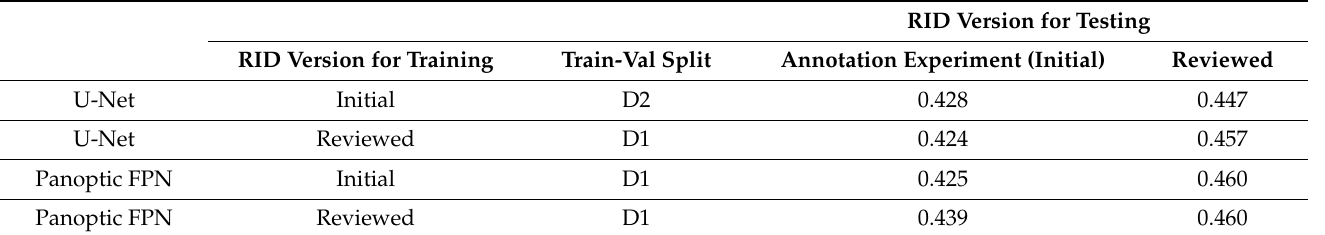
Table 2. IoUs of selected CNNs trained and tested on initial and reviewed ground truth,